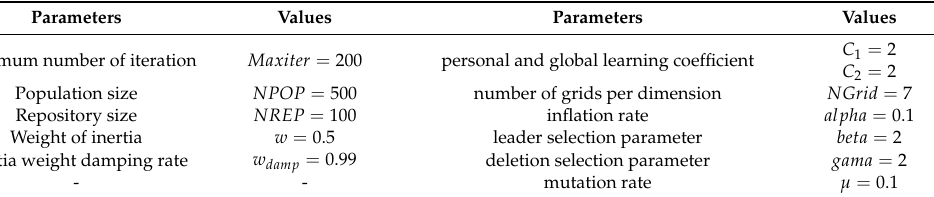
Table 1. Input parameters of MOPSO.